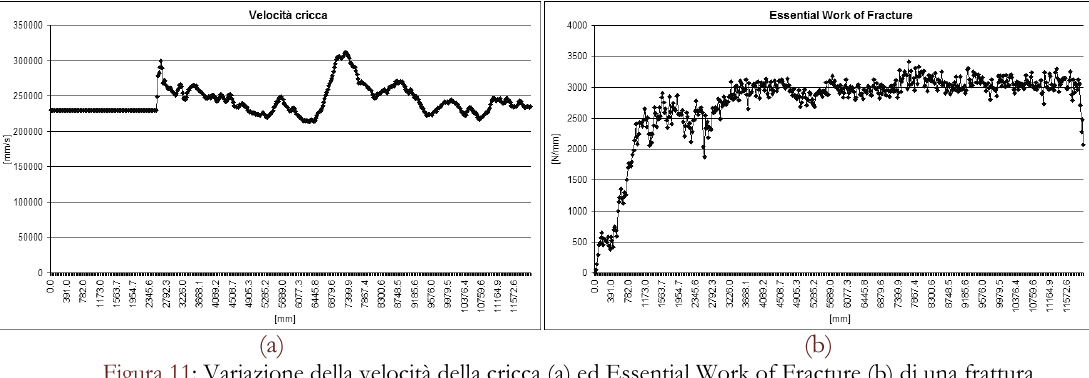
Figura 11: Variazione della velocità della cricca (a) ed Essential Work of Fracture (b) di una frattura